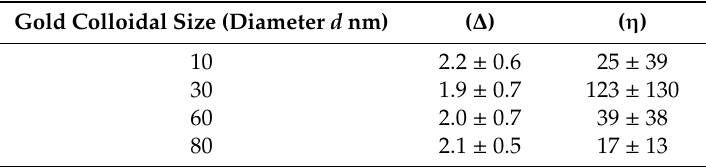
Table 1. The average distance, ( ∆ ), of adjacent β 2m-coated nano-gold colloids and the average number ( η ) of gold colloids consisting in an aggregate (gold colloid cluster) at pH 4.0 ± 0.3. Gold Colloidal Size ( Diameter d nm )